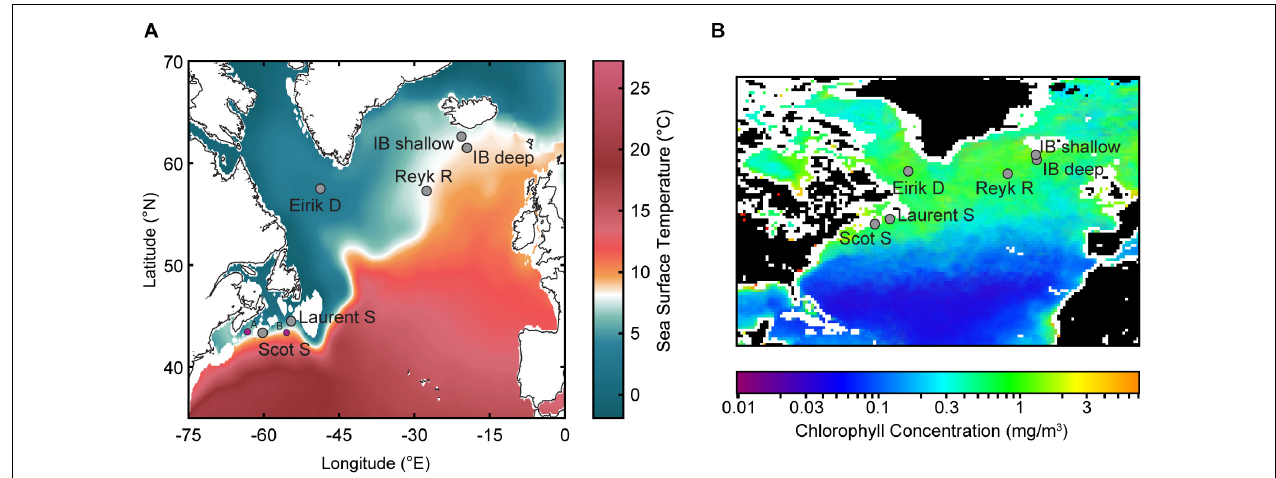
FIGURE 1 | The subpolar North Atlantic with locations of core sites used in this study (see Table 1 ). (A) Colors indicate the mean annual climatological sea-surface temperature (SST; ◦ C) from the World Ocean Atlas (Locarnini et al., 2013). Purple circles indicate A, OCE-326-30GGC/MC29 (Emerald Basin; Keigwin et al., 2003), and B, OCE-326-14GGC/MC13 (Laurentian Fan; Keigwin and Pickart, 1999). (B) Ocean color data of average annual chlorophyll in 2010 (mg/m 3 ) from Sea-viewing Wide Field-of-view Sensor (SeaWiFS) Ocean Color Data (NASA Goddard Space Flight Center, Ocean Ecology Laboratory, and Ocean Biology Processing Group, 2018